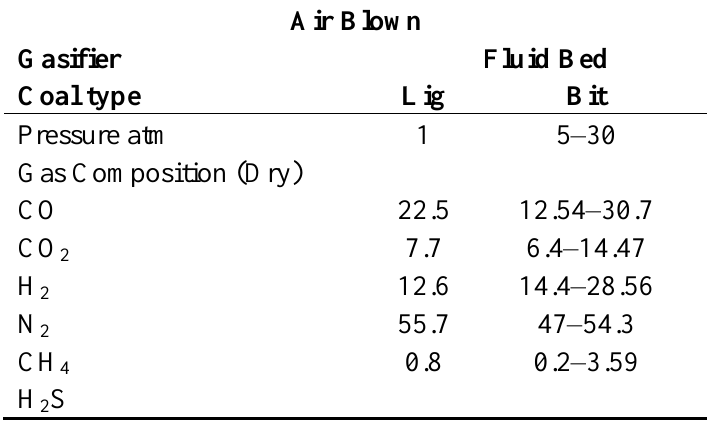
Table 7. Gas composition for air blown fluidized bed gasifiers